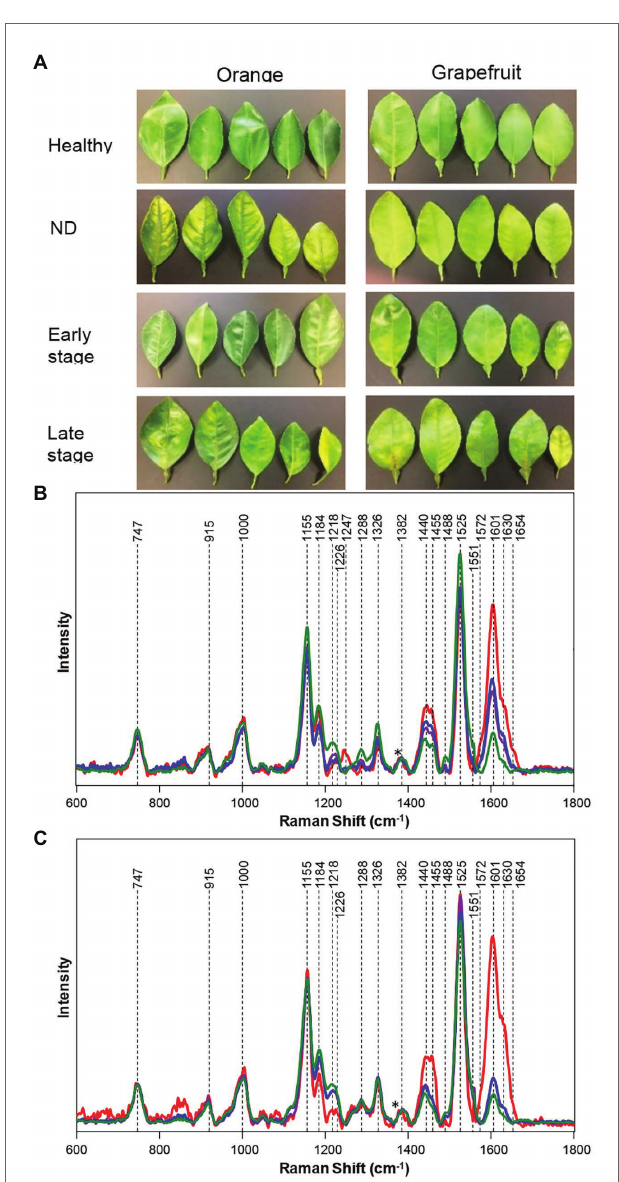
FIGURE 4 | Leaf samples collected from fields for qPCR assay and Raman spectrum (A) . Raman spectra generated from leaves of healthy (green), HLB- infected on late (blue) and early (purple) stages, and ND symptoms (red) in grapefruit (B) , and orange (C) trees. Spectra normalized on cellulose vibrational bands [marked by asterisks ( * )]. Reproduced with permission from Sanchez et al.